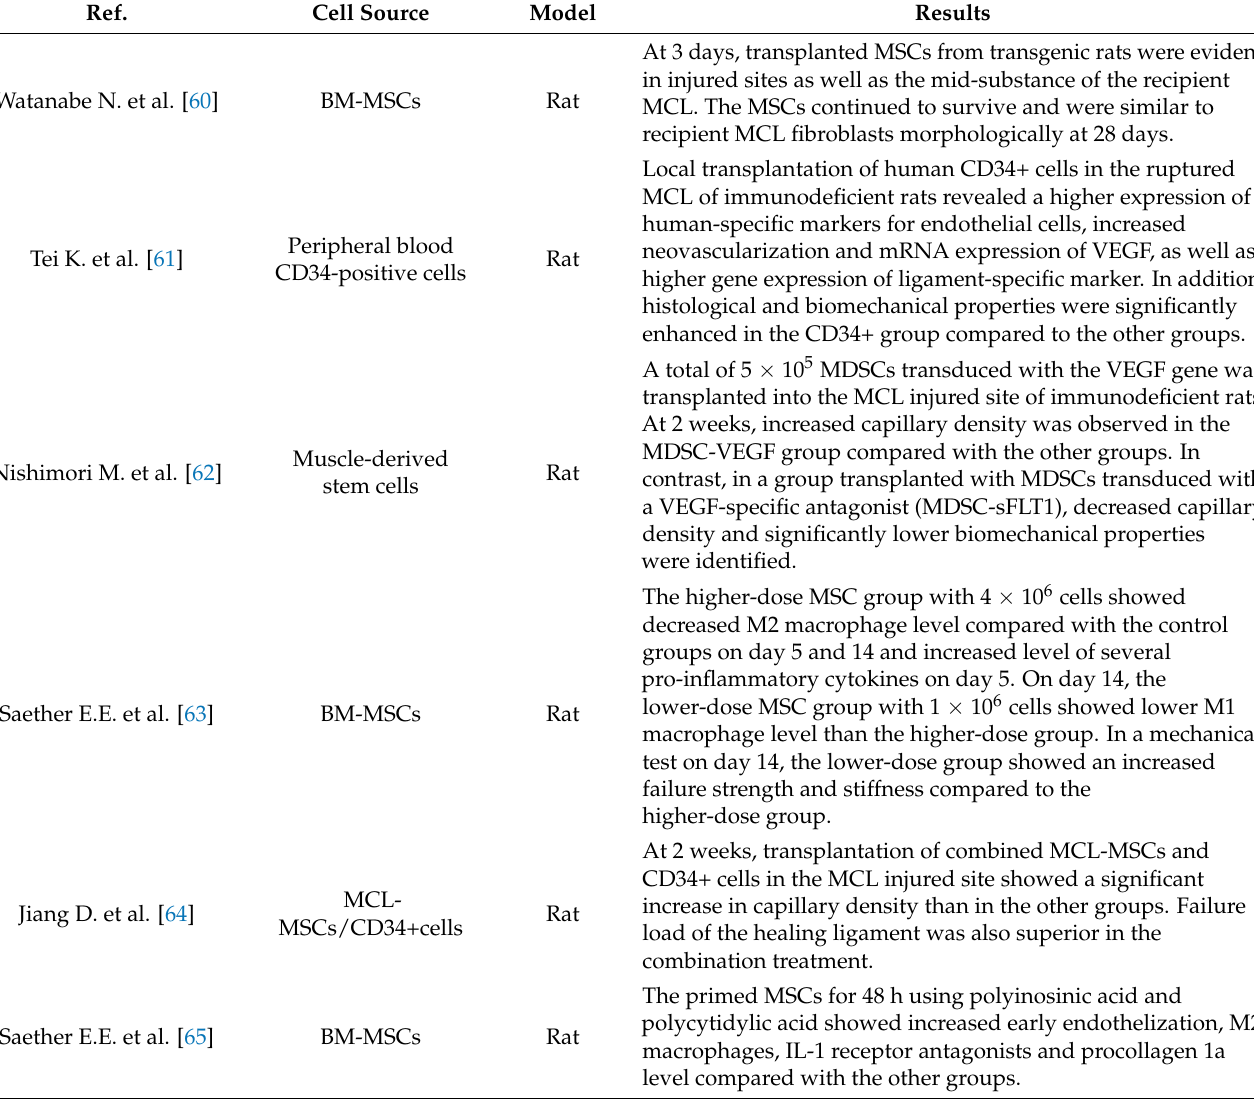
Table 1. Summary of recent studies regarding MSCs for enhanced healing of the MCL.